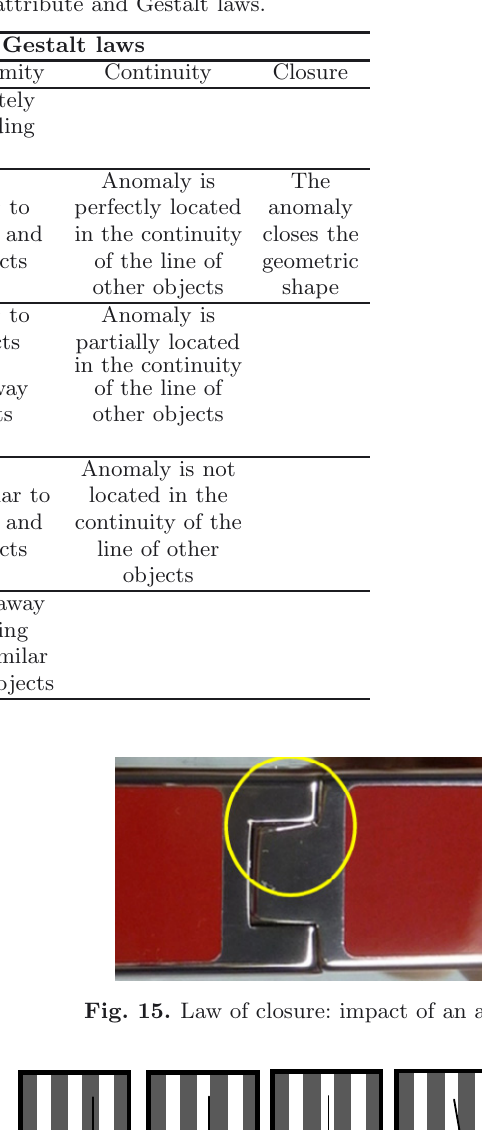
Table 4. “Local impact” attribute and Gestalt laws.